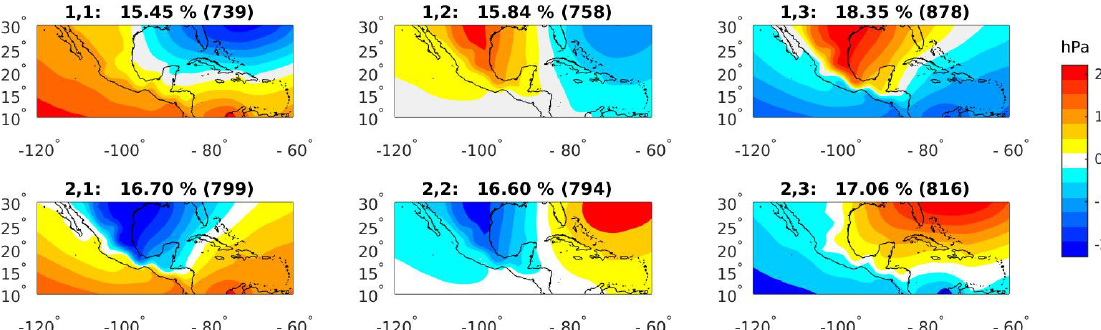
Figure 2. Reference weather patterns for mean sea level pressure (mslp) obtained from self-organizing maps (SOM) with ERA-Interim data for the period 1980–2005. The patterns are expressed in anomalies with respect to the long-term mean. The position (i, j) of each pattern in the matrix, relative frequency (in %), and total number of days are indicated at the top of each